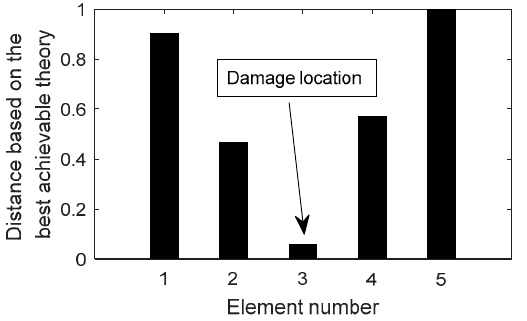
= i δ ' ( 5~1 ) for the experimental beam when segment 3 is damaged. i ( i = 1 ∼ 5) for the experimental beam when segment 3 is damaged. i